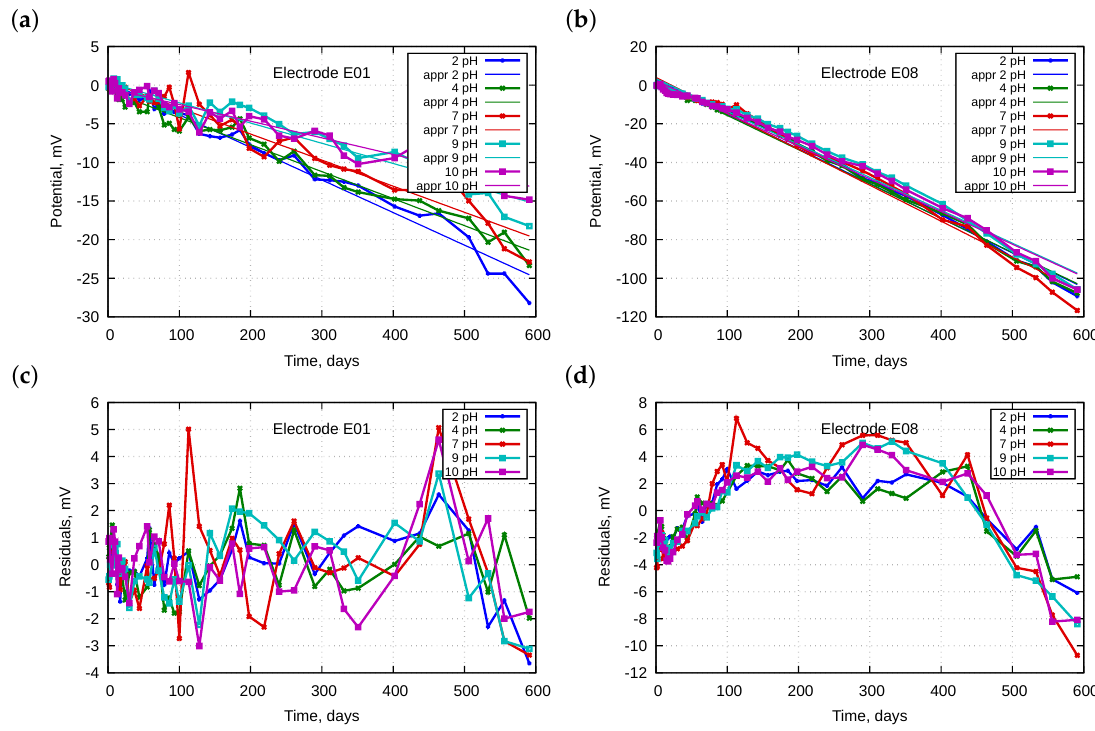
Figure 2. Examples of electrode potential changes: ( a , b ) standardized potentials with fitted straight lines as a function of time for electrodes E01 and E08, respectively; and ( c , d ) with corresponding residuals.